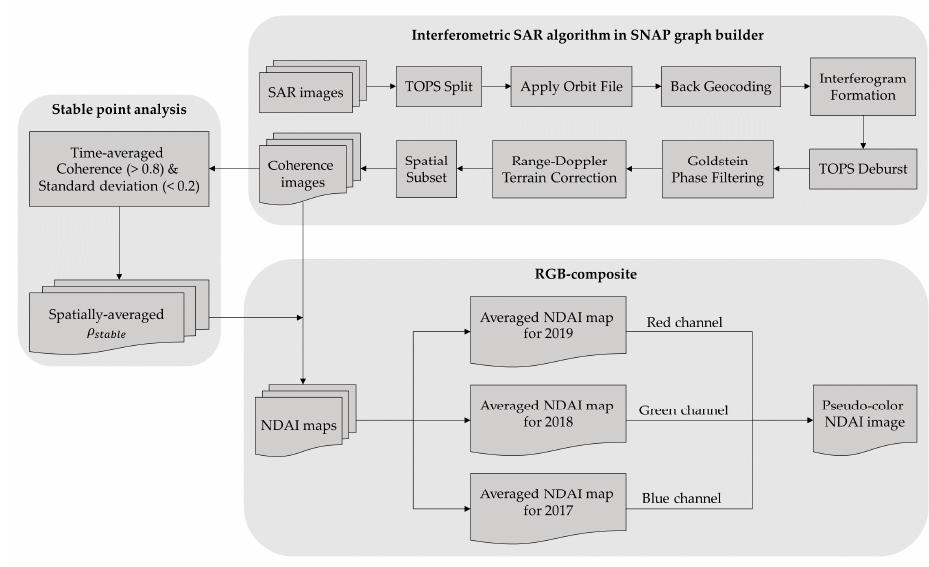
Figure 3. Flow chart of data processing.